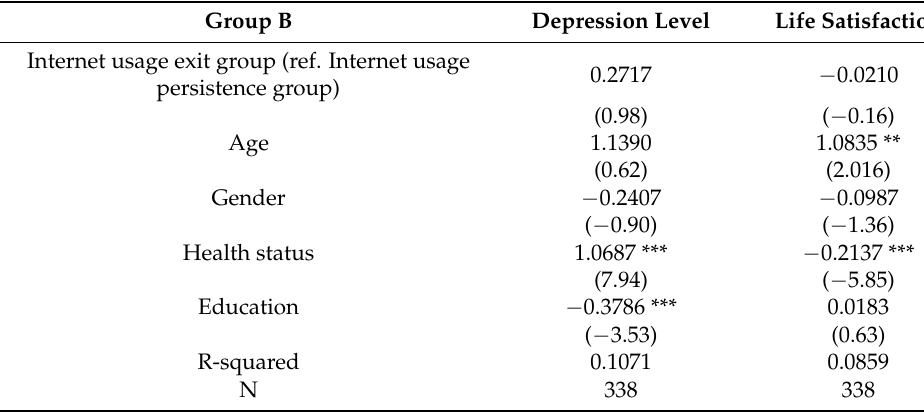
Table 5. Results of the DiD estimation (group